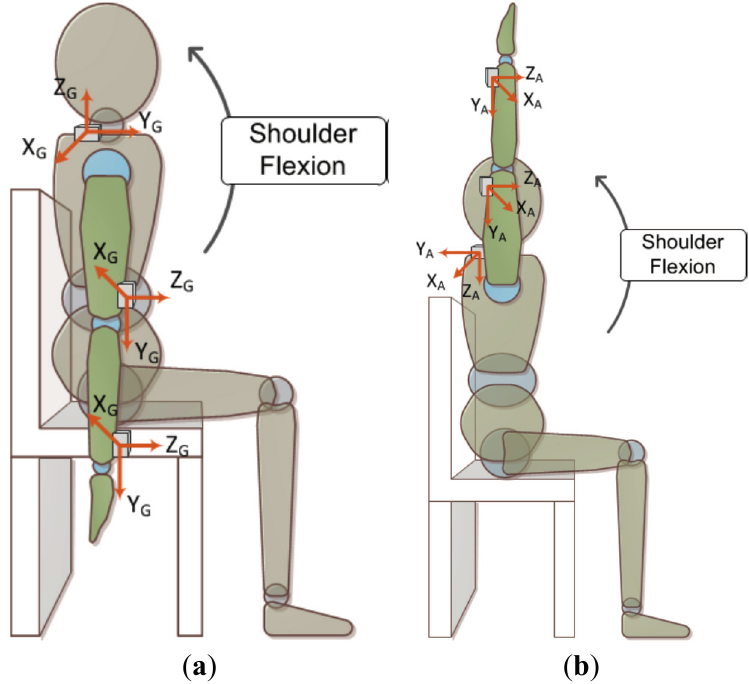
Figure 2. Illustration of sensors’ placement and assessment motion. ( a ) The initial position of shoulder flexion and motion direction, and the 3-axis directions of gyro marked by the subscript “G”; ( b ) The end position of shoulder flexion, and the 3-axis directions of accelerometer marked by the subscript